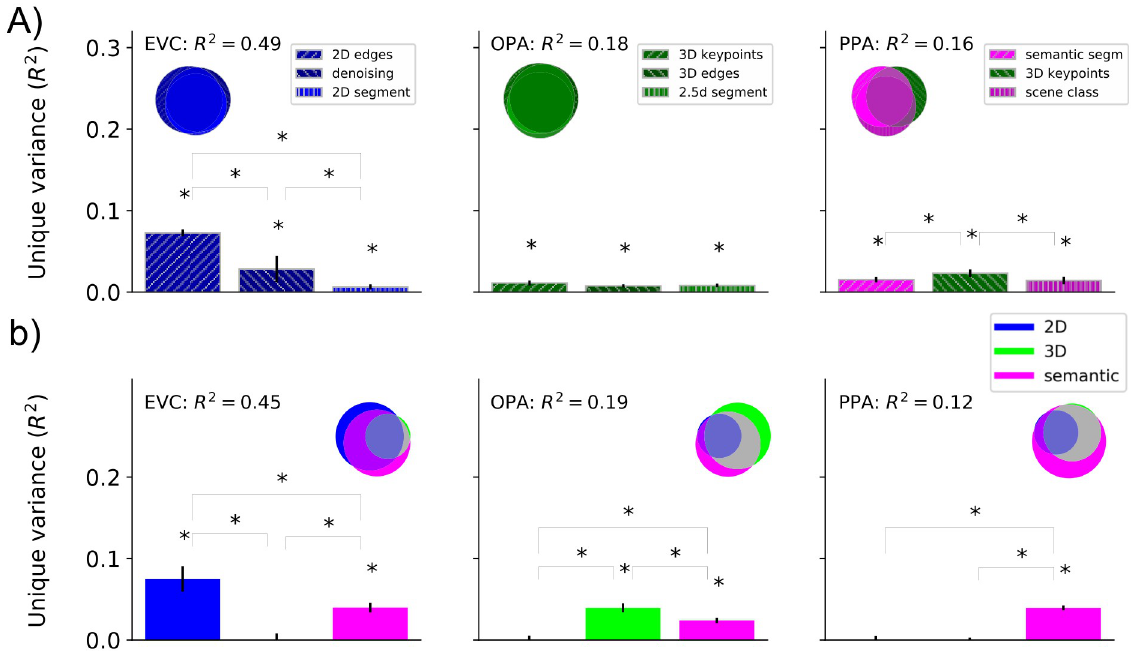
Fig 4. Functional roles of localized ROIs. A) Absolute total variance (R 2 ) explained in functionally localized ROIs by using the top-3 DNNs together. The Venn diagram for each ROI illustrates the unique and shared variance of the ROI responses explained by the combination of the top-3 DNNs. The bar plot shows the unique variance of each ROI explained by each of the top-3 DNNs individually. The asterisk denotes the significance of unique variance and the difference in unique variance (p < 0.05, permutation test with 10,000 iterations, FDR-corrected across DNNs). The error bars show the standard deviation calculated by bootstrapping 90% of the conditions (10,000 iterations). B) Absolute total variance (R 2 ) explained in functionally localized ROIs by using 3 DNN RDMs averaged across task groups (2D, 3D, or semantic). The Venn diagram for each ROI illustrates the unique and shared variance of the ROI responses explained by the combination of 3 DNN task groups. The bar plot shows the unique variance of each ROI explained by each task group individually. The asterisk denotes whether the unique variance or the difference in unique variance was significant (p < 0.05, permutation test with 10,000 iterations, FDR-corrected across DNNs). The error bars show the standard deviation calculated by bootstrapping 90% of the conditions (10,000 iterations).